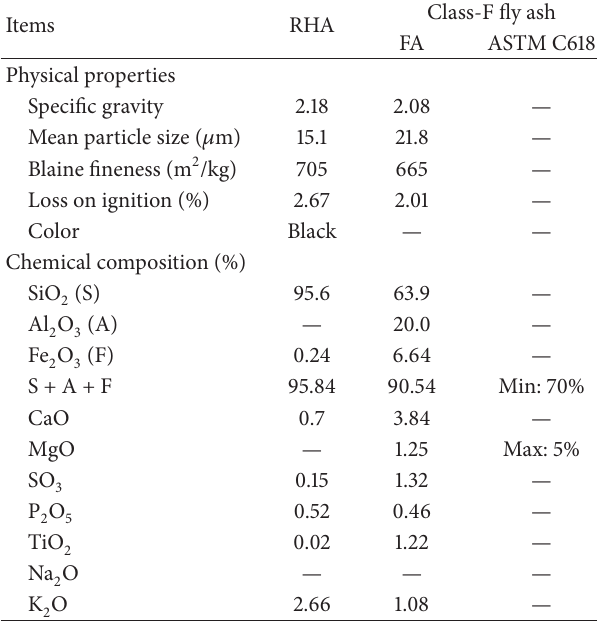
Table 1: Physical and chemical analyses of RHA and